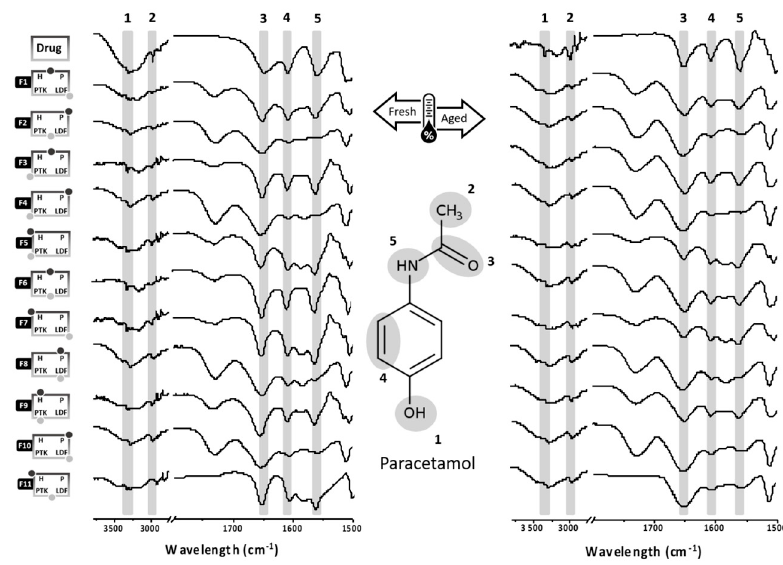
Figure 1. FTIR of the paracetamol as supplied and the effervescent extrudates obtained according to a combined mixture design before and after aging.